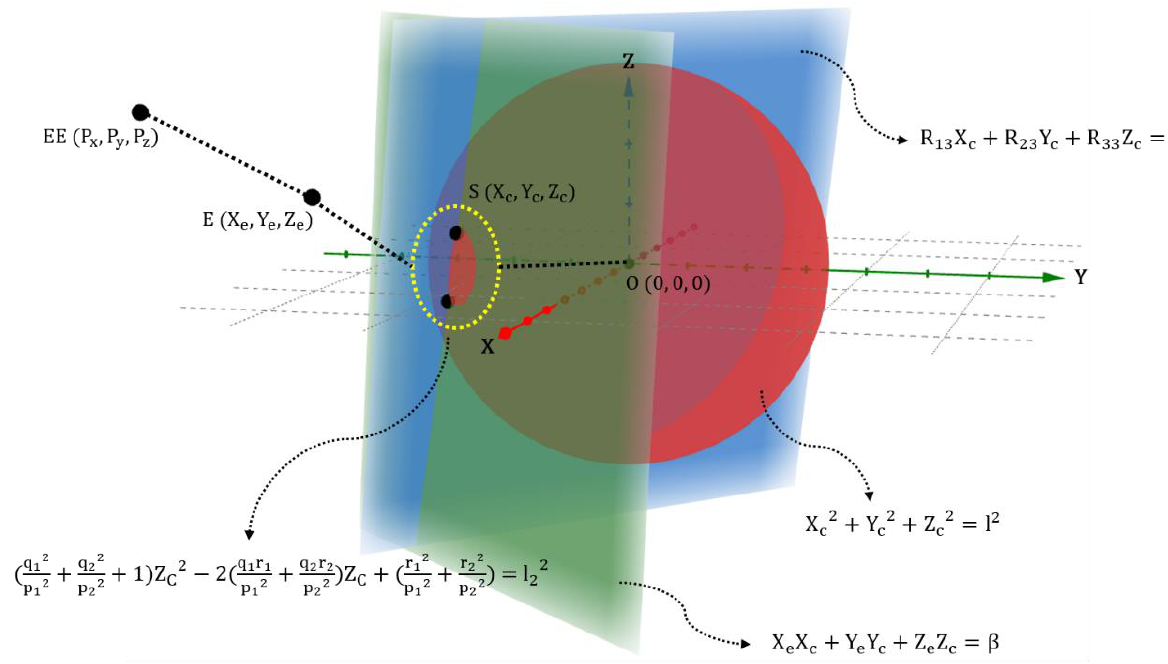
Figure 5. Two shoulder position vectors that are expressed through three-dimensional space.